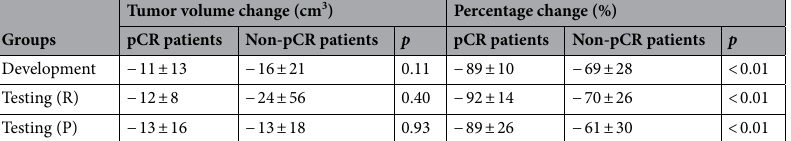
Table 3. Tumor volume change between the baseline and C4 MRI for the development, retrospective independent testing, and prospective blinded testing groups. pCR pathological complete